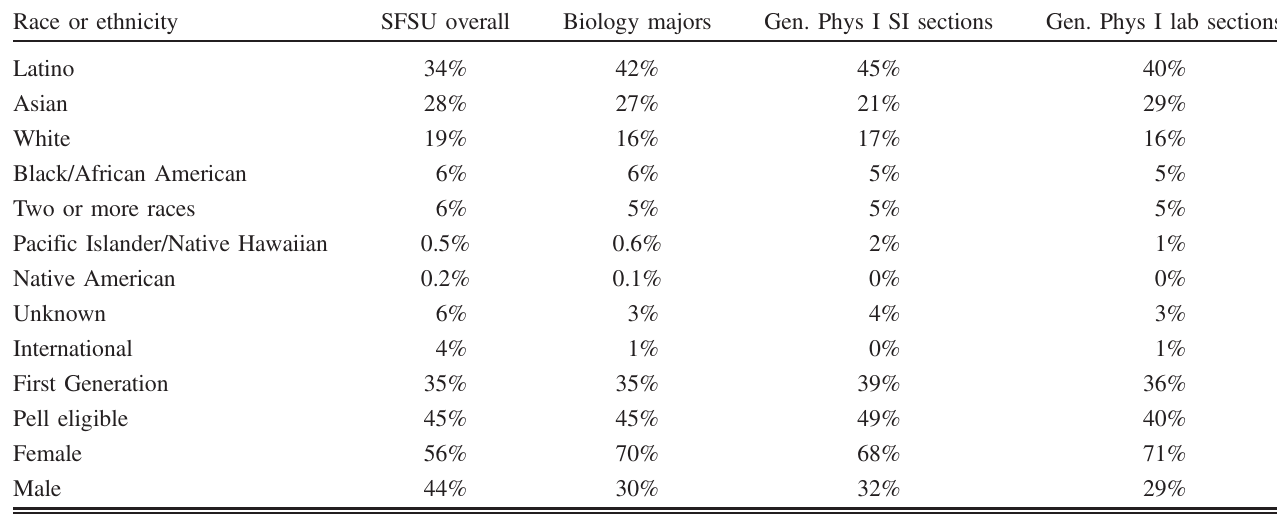
TABLE II. Demographic information for SFSU undergraduates overall, biology majors at SFSU in general, and the sections of General Physics I Supplemental Instruction (SI) and lab that participated in this study. Information on race or ethnicity, first-generation status, Pell eligibility, and gender illustrate the diversity of our university along several socially constructed axes as collected by our Institutional Research Office. We did not separately collect demographic information on the participants. We note the limitations of the institutional categories. SFSU is a public, masters-granting university that serves just under 30 000